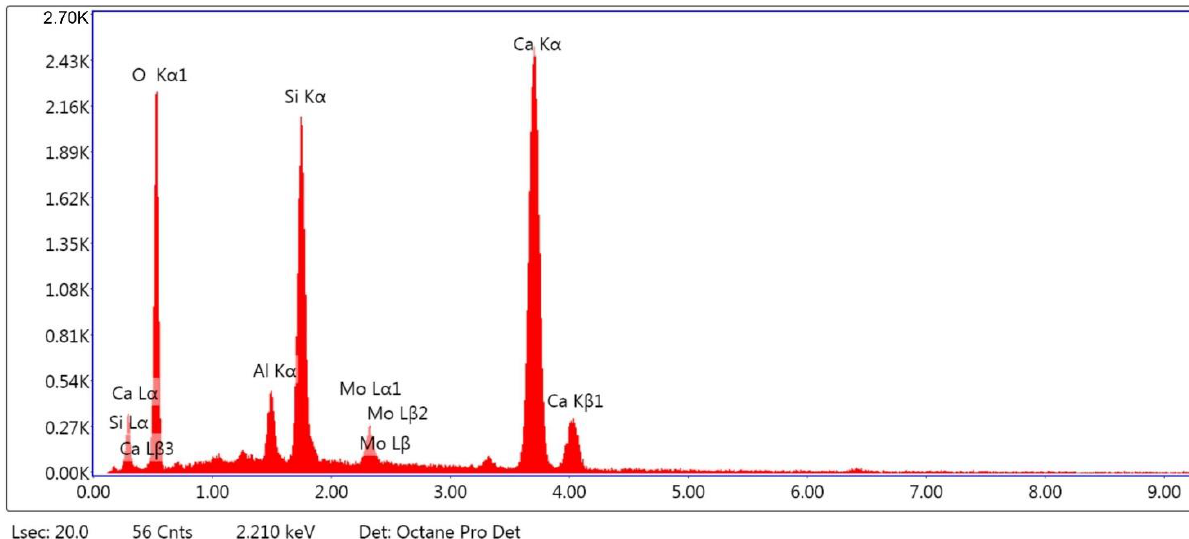
Figure 6. EDS element content analysis in recycled fines shown in Figure 5b. Table 4. The results of the elemental composition analysis of recycled fines.